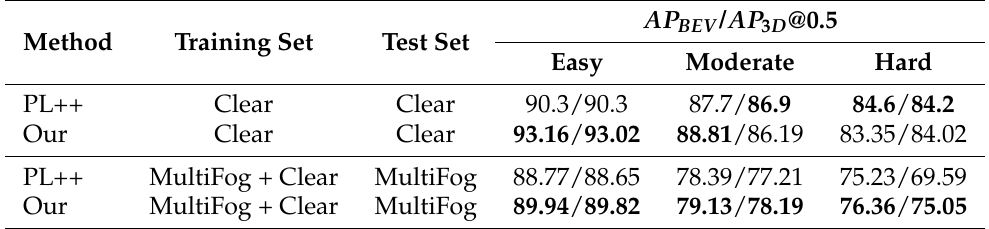
Table 3. Comparison with Pseudo-LiDAR++ [68] method, with IoU = 0.5, best results shown in bold.